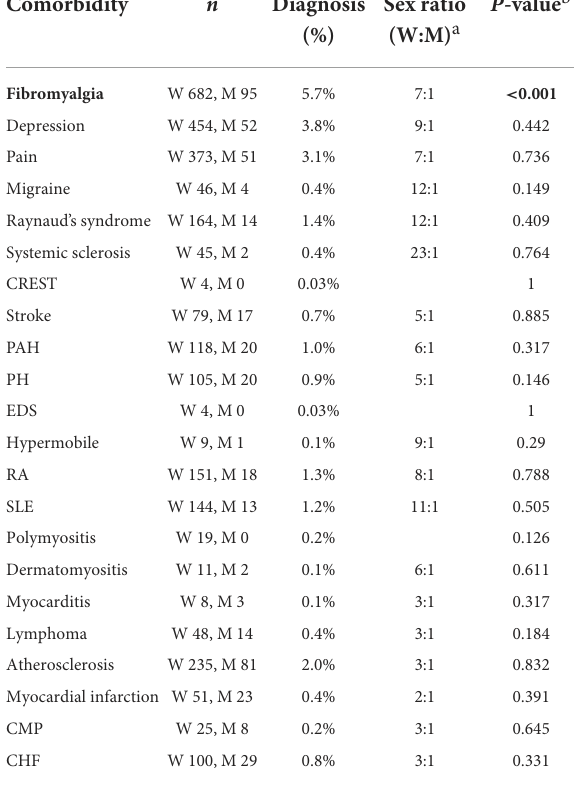
TABLE 6 Autoantibodies in male Sjögren’s disease patients by age. TABLE 7 Likelihood of having a comorbidity by sex at Sjögren’s disease diagnosis ( n = 13,849).